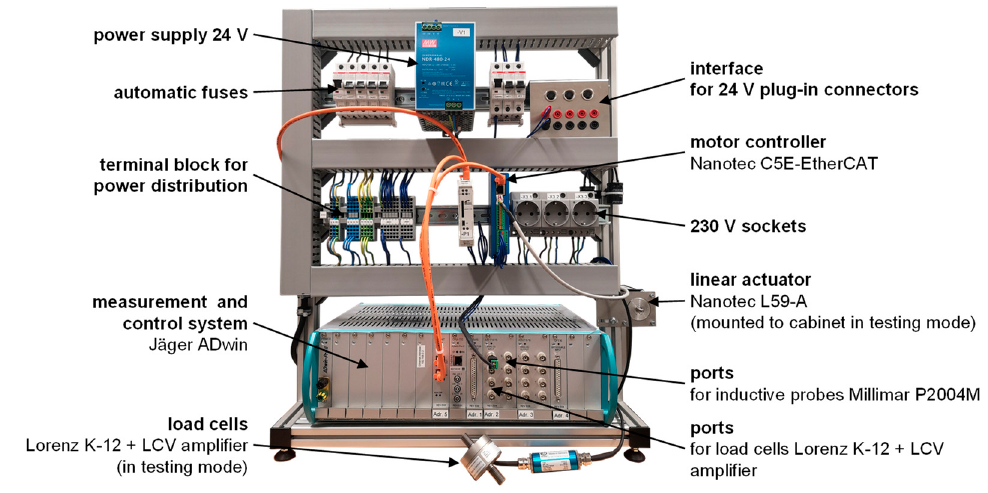
Figure 6. Realized control cabinet for sensor and actuator integration and control in testing mode.